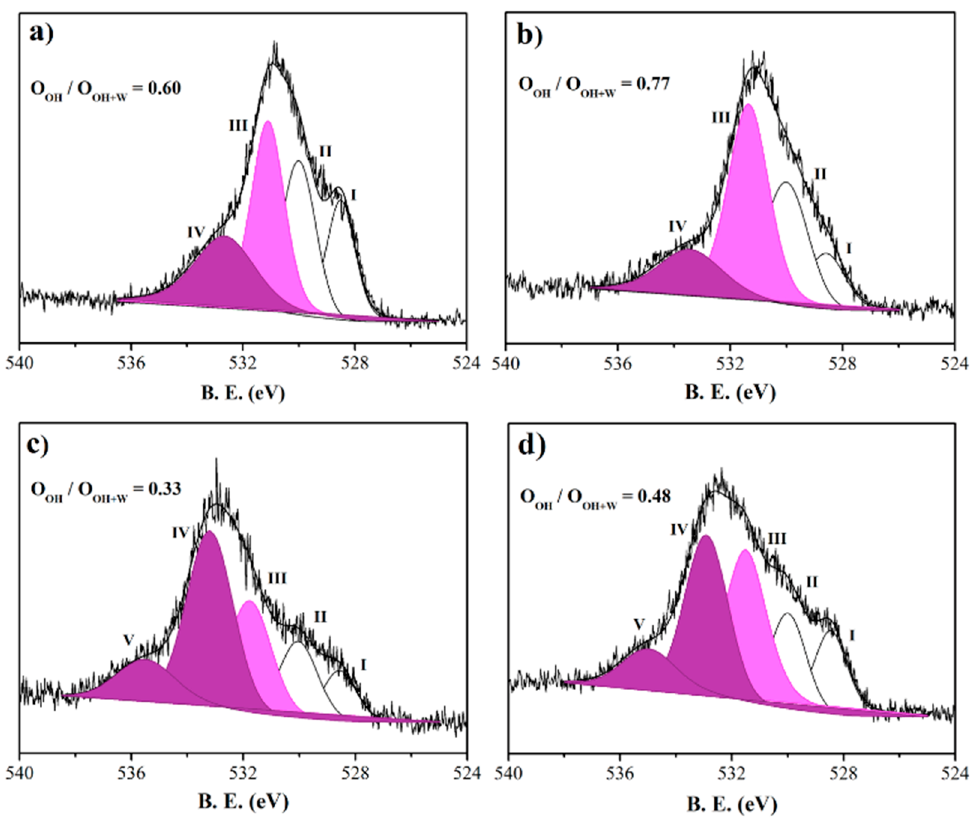
Figure 6. XPS high-resolution spectra of oxygen (O1s) relative to ( a ) Mn 20 1077_3; ( b ) Mn 20 1077_4; ( c ) Mn 20 1077_9; and ( d ) Mn 20 1077_12. Inset: Atomic ratio between the oxygen of surface OH groups (O OH , pink area), and the sum of the previous one and the oxygen of the chemisorbed water molecules (O W , violet areas).